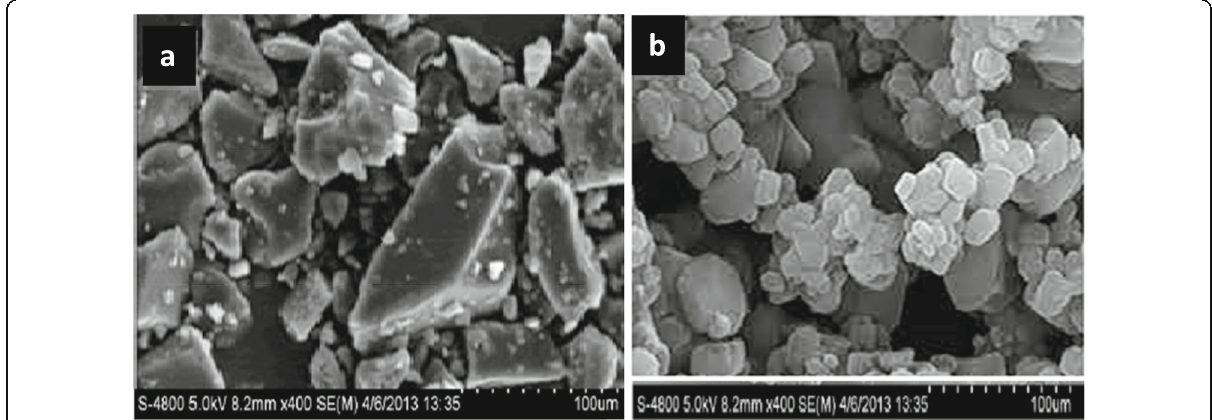
Fig. 7 SEM images of a pure fenofibrate and b fenofibrate